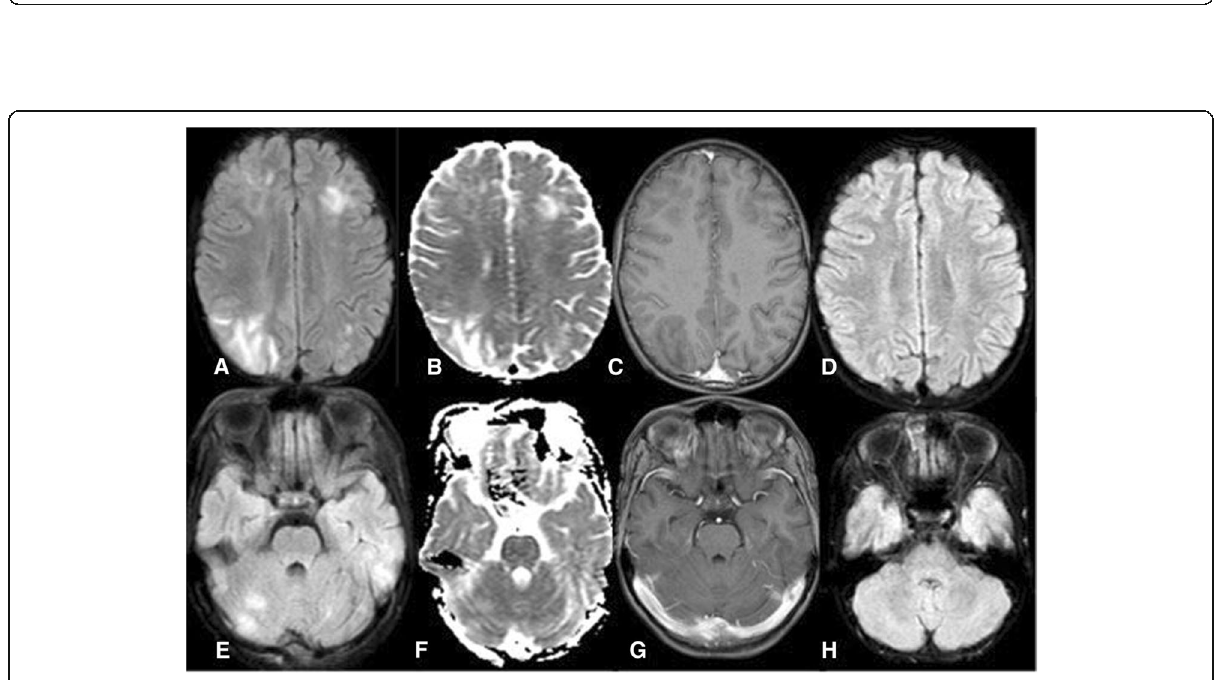
Fig. 4 MRI examination of an 8-year-old post-allogenic HSCT patient presenting with convulsions and disturbed conscious. a & e axial FLAIR images revealing bilateral frontal, parietal, occipital (not shown in images), and cerebellar asymmetrical cortical and subcortical high FLAIR signal. b & f ADC maps showing bilateral frontal, parietal, and occipital high signal impressive of facilitated diffusion. c & g Contrast-enhanced axial image showing no evident post-contrast enhancement. The patient was diagnosed with posterior reversible encephalopathy syndrome (PRES). d & h Follow up axial FLAIR images showing total resolution of the previously noted altered cortical and subcortical signal with no residual